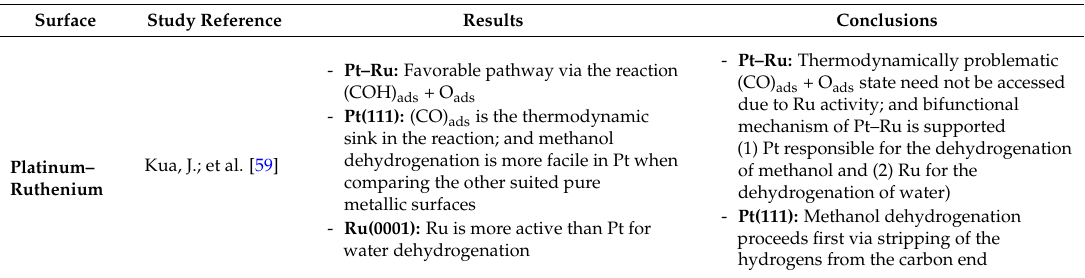
Table 4. Selected data from the computational studies per catalyst on chronological